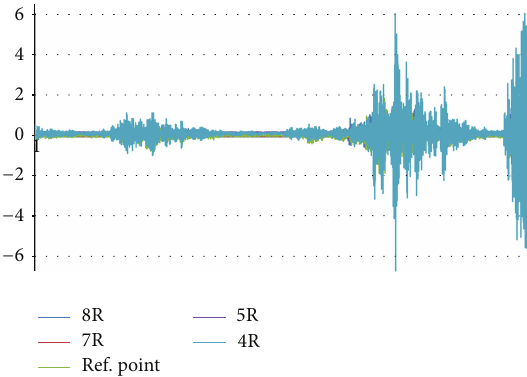
Figure 10: Comparison of vertical